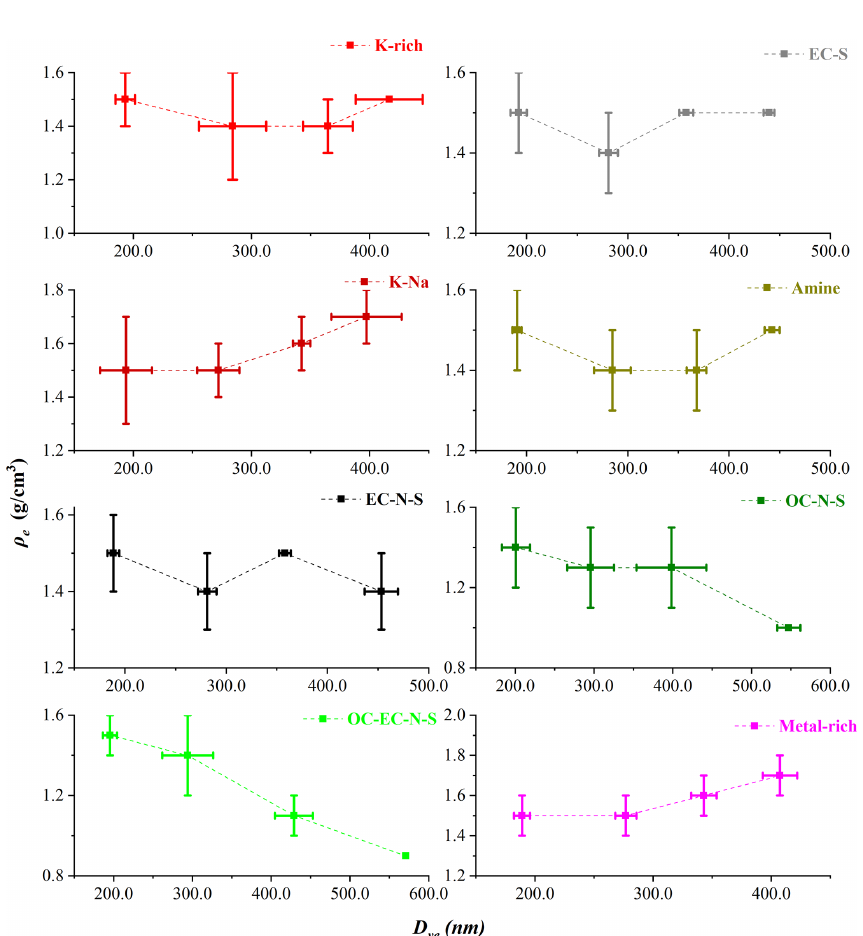
Figure 4. Variation in ρ e of the eight particle types with D ve . The solid lines represent the range of the ρ e and D ve measured from nine rounds, and the data points stand for the average